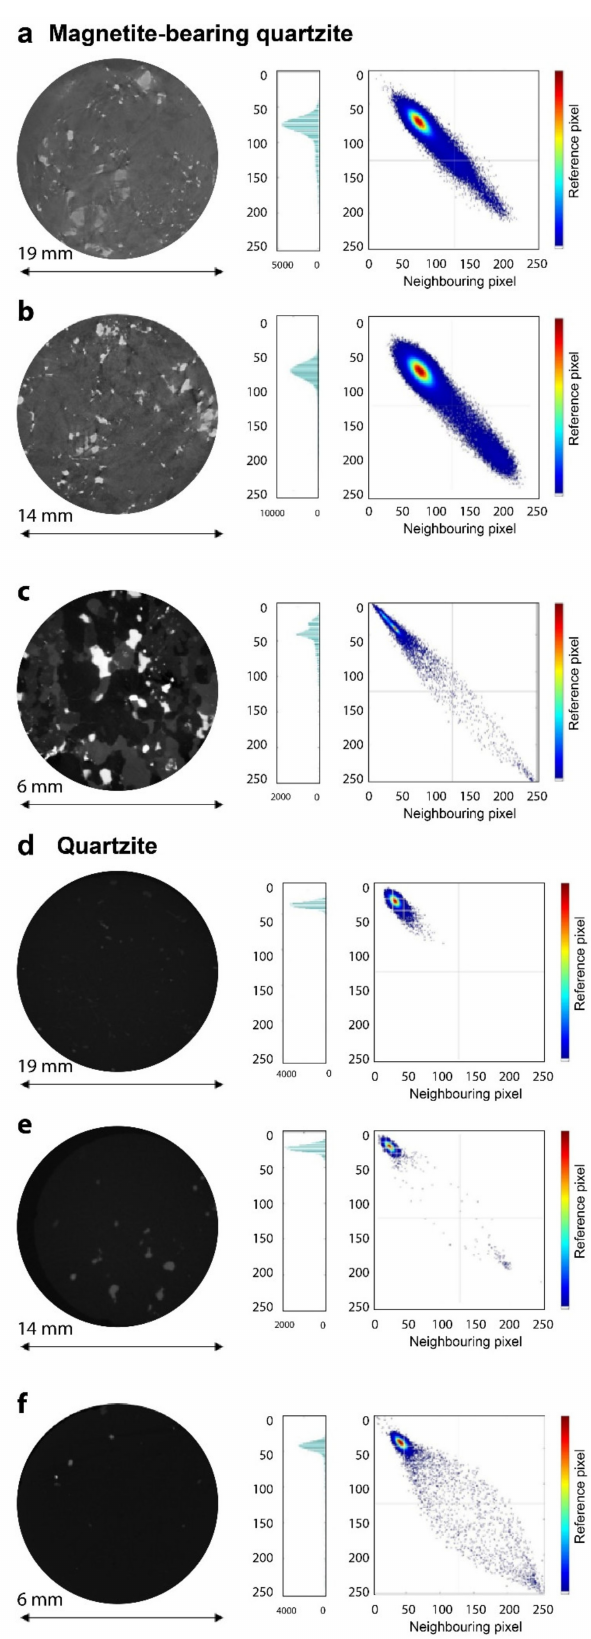
Figure 6. 3D GLCM heat map and histogram distributions of the three di ff erent core sizes of 19, 14 and 6 mm for the polymetallic magnetite-bearing quartzite ( a – c ) and quartzite ( d – f